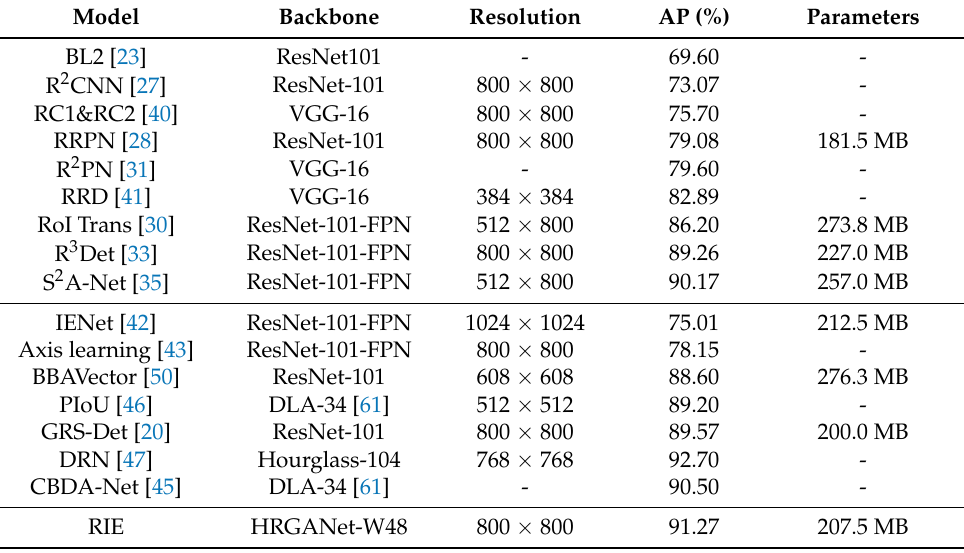
Table 3. Comparison of the results of accuracy and parameters on the HRSC2016